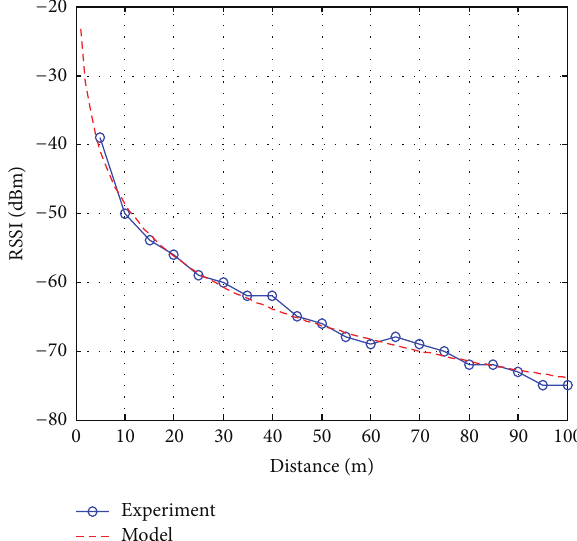
Figure 6: WiFi probabilistic propagation model.